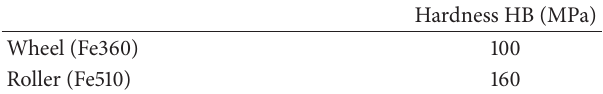
Table 4: Values of the Brinell hardness of the wheel and the